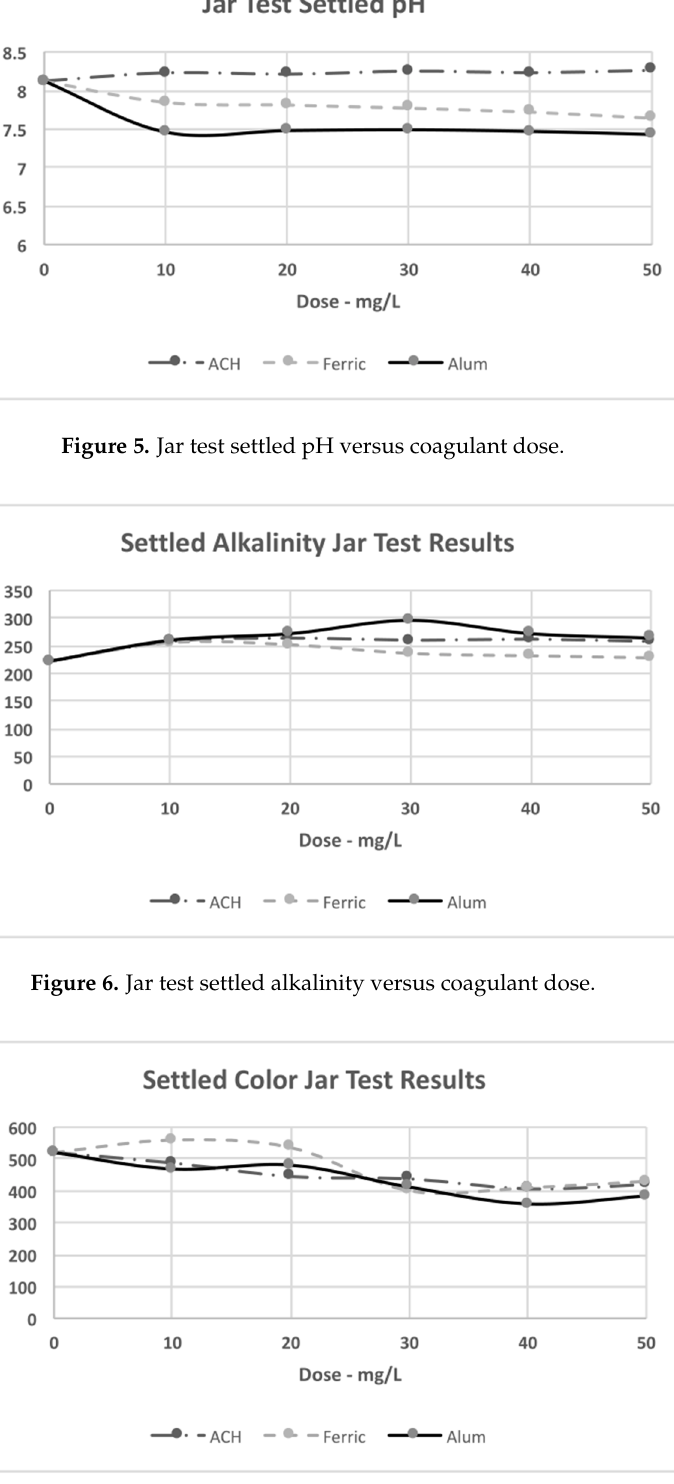
Figure 7. Jar test settled color versus coagulant dose.